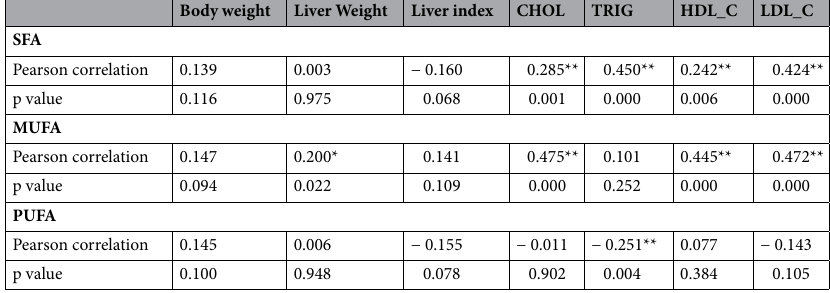
Table 2. Correlation analysis between three edible oil components and body weight, liver weight and cholesterol concentration. *p < 0.05; **p < 0.01.